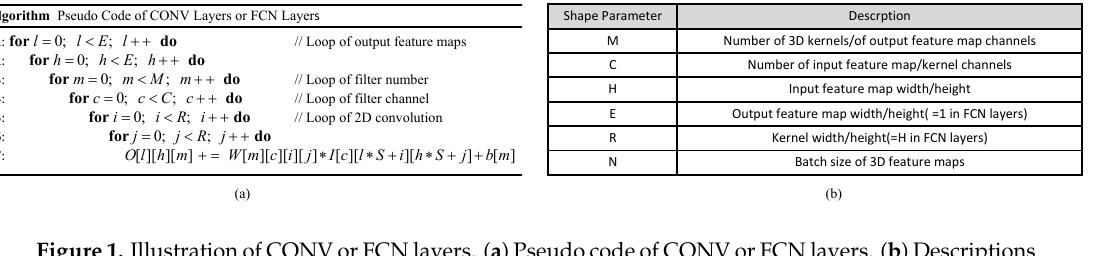
Figure 1. Illustration of CONV or FCN layers. ( a ) Pseudo code of CONV or FCN layers. ( b ) Descriptions of CONV or FCN layer